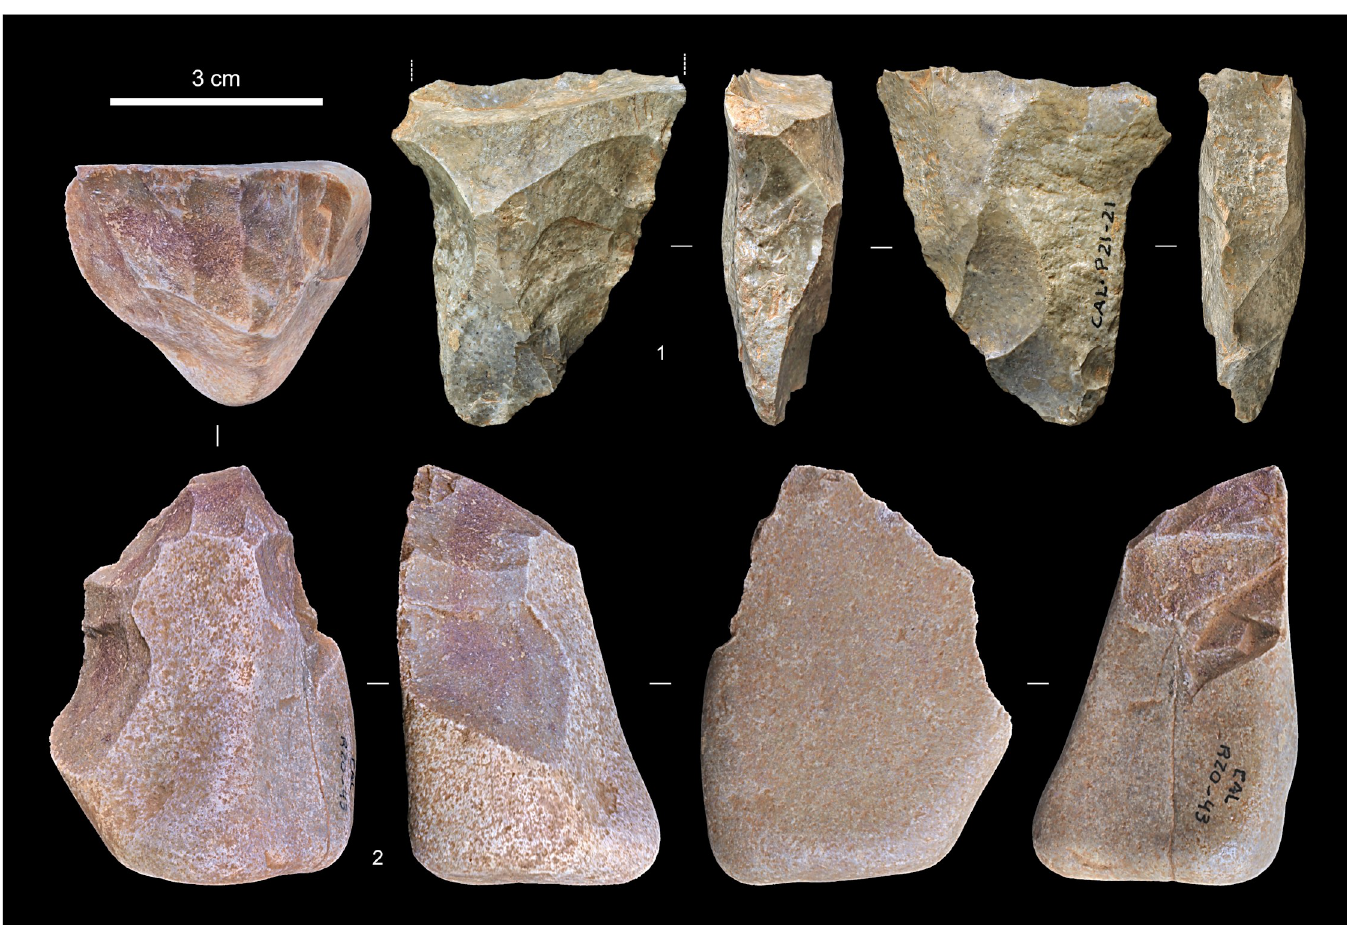
Fig 18. Entrance trench: Upper Palaeolithic artefacts. 1. Bifacial preform fragment, chert (P21-21, Unit 2). 2. Carinated scraper/core, quartzite (R20-43, Unit 4).